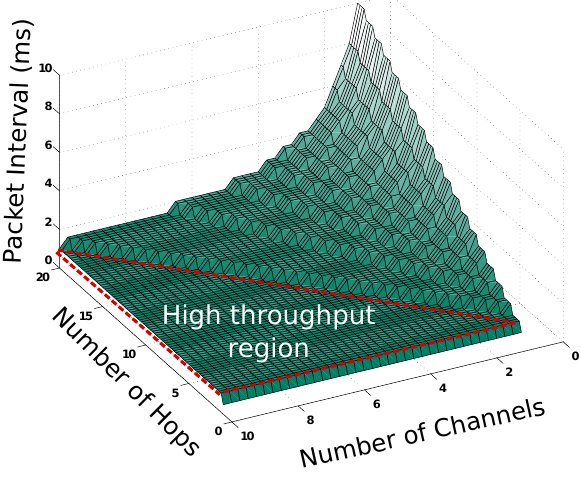
Figure 6. Given the expected maximum network distance (number of hops) from the MAV to the base station, a number of channels can be allocated to the MAV burst mode. As long as the number of channels is at least half the number of hops, the MAV will be able to communicate at the maximum supported throughput of the network given one unique path to the base